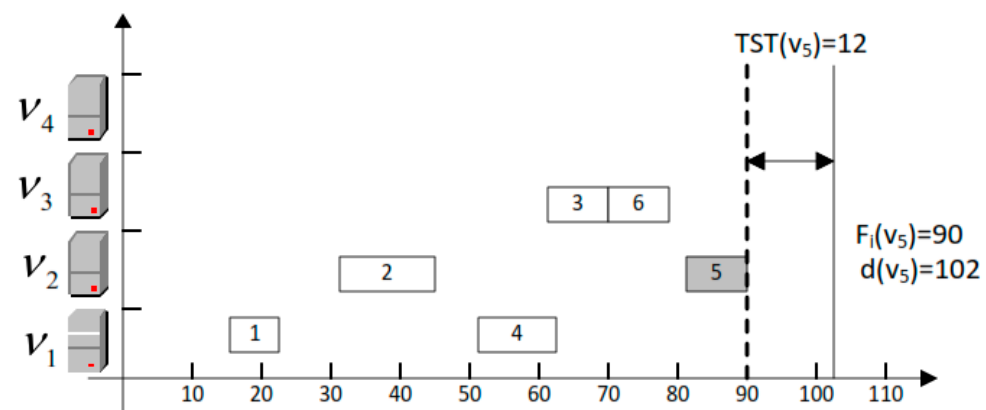
Sensors 2019 , 19 , x FOR PEER REVIEW Figure 3. The task v 5 with TST (v 5 = 12) sequence adjustment. Figure 3. The task v 5 with TST (v 5 = 12) sequence adjustment.